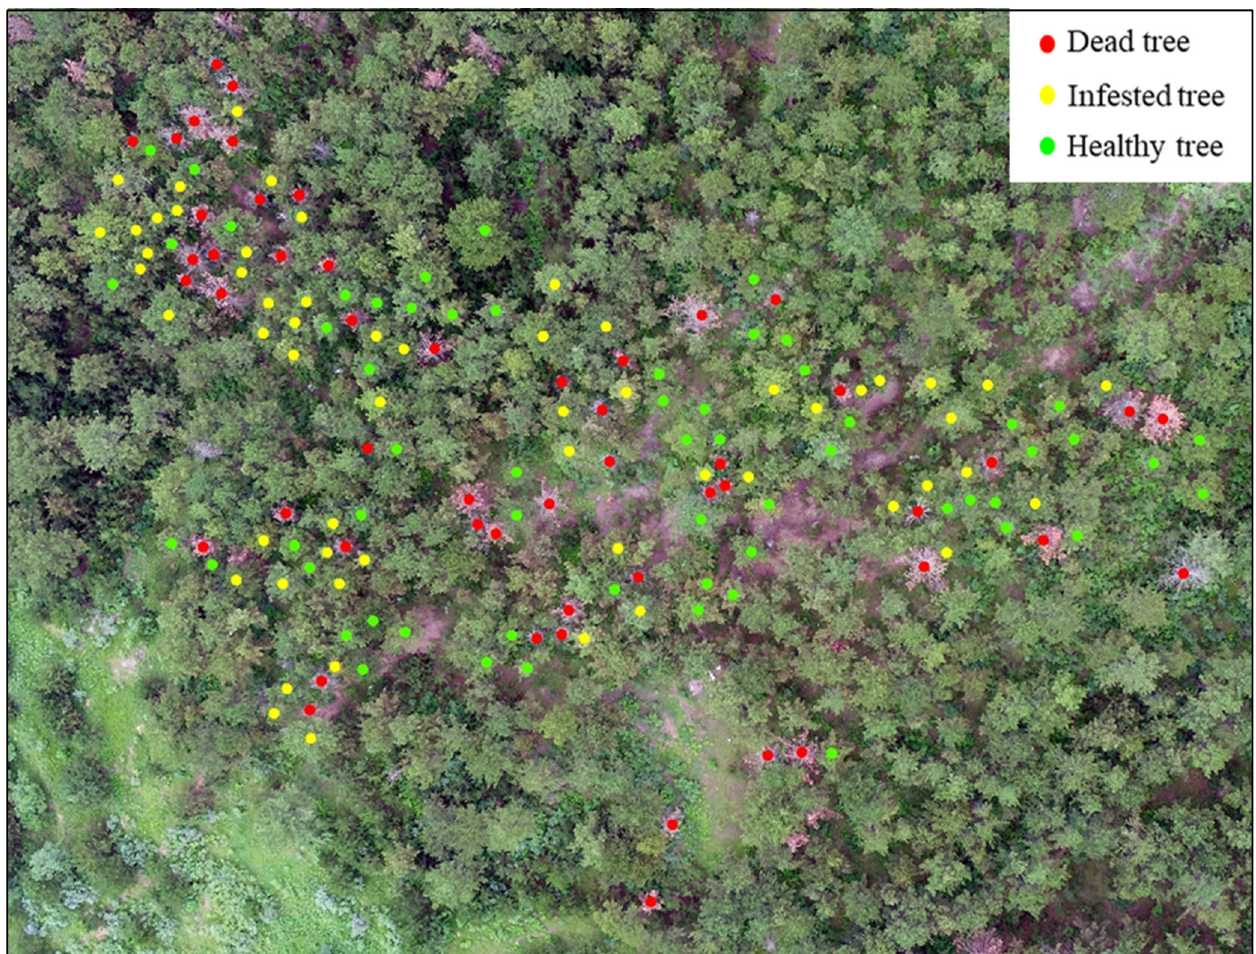
Figure 4. A high ‐ resolution orthophoto with dots representing the health status of trees assessed through the field survey. Red dots: dead trees; yellow dots: infested trees; green dots: healthy trees.